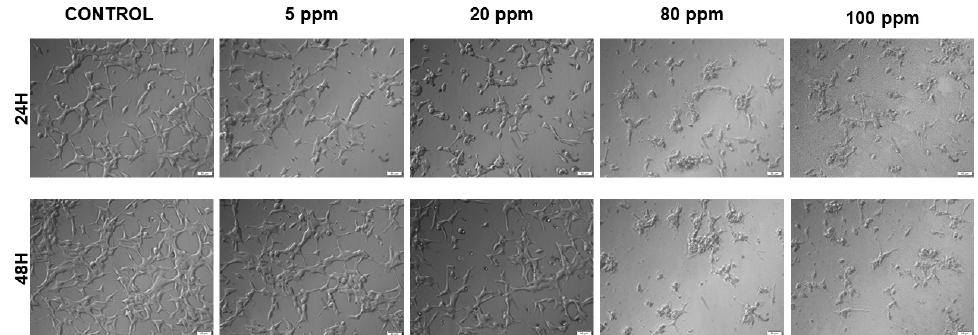
Figure 2. Bright field microscopy images of LNCaP cell morphology after exposure to different concentrations of AgNPs ranging from 5 to 100 ppm, for 24 h and 48 h (20× OLYMPUS IX51 microscope).